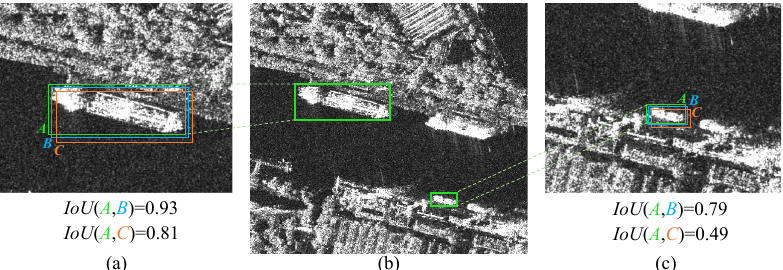
Figure 2. IoU of a large ship and a small ship. ( a ) Large ship detection. ( b ) SAR image. ( c ) Small ship detection. A is the ground truth bounding box, B and C are the proposal bounding boxes with one- and three-pixel location deviations,